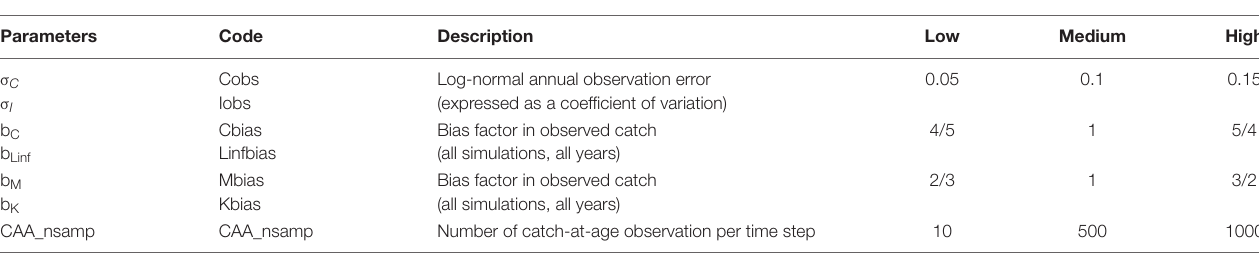
FIGURE 1 | Parameter performance with time-series data. (A) Annual catch/index observation error distribution in low (0.05), medium (0.1), and high (0.15) level. (B) Simulated real catch with low (0.05), medium (0.1), and high (0.15) level observation error. (C) Catch level with low (4/5), medium (1), and high (5/4) level bias in Cbias and Linfbias. (D) Catch level with low (2/3), medium (1), and high (3/2) level bias in Mbias and Kbias. TABLE 1 | Parameter settings in striped marlin case